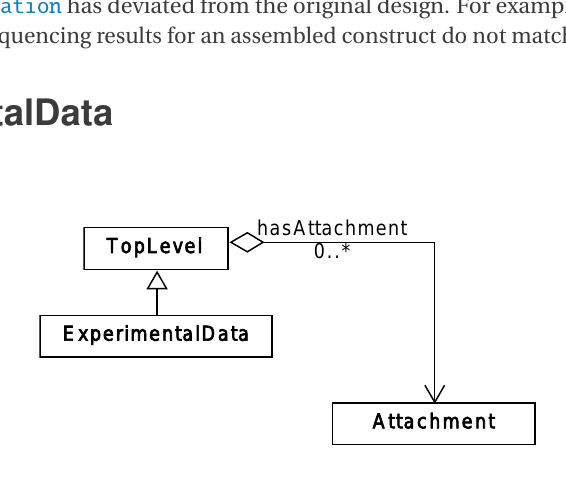
Figure 18: Diagram of the ExperimentalData class and its associated properties.